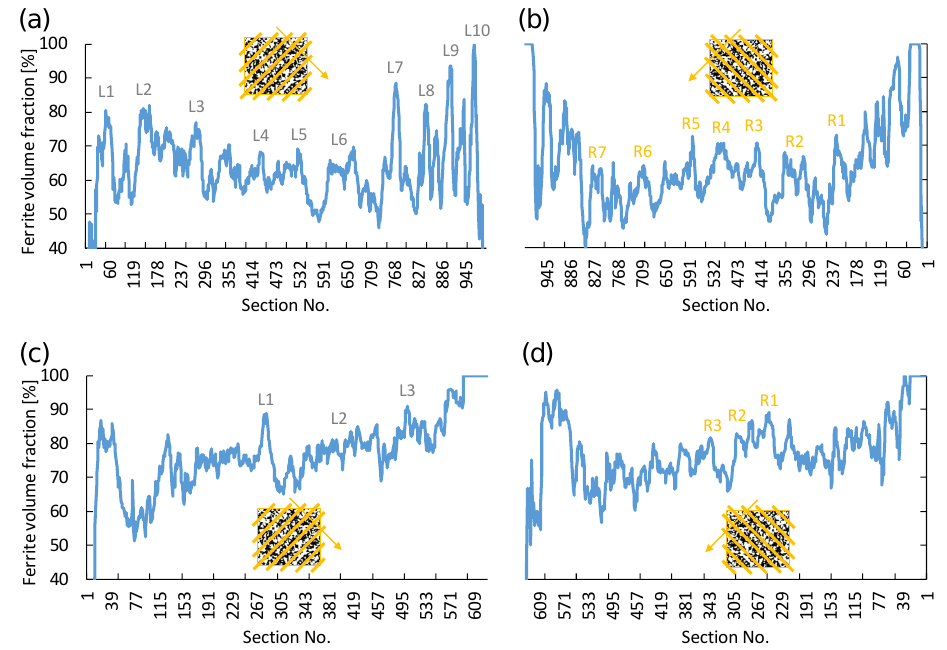
Figure 19. Ferrite volume fraction in each cross section: ( a ) from upper left to lower right in DP5; ( b ) from upper right to lower left in DP5; ( c ) from upper left to lower right in DP2; and ( d ) from upper right to lower left in